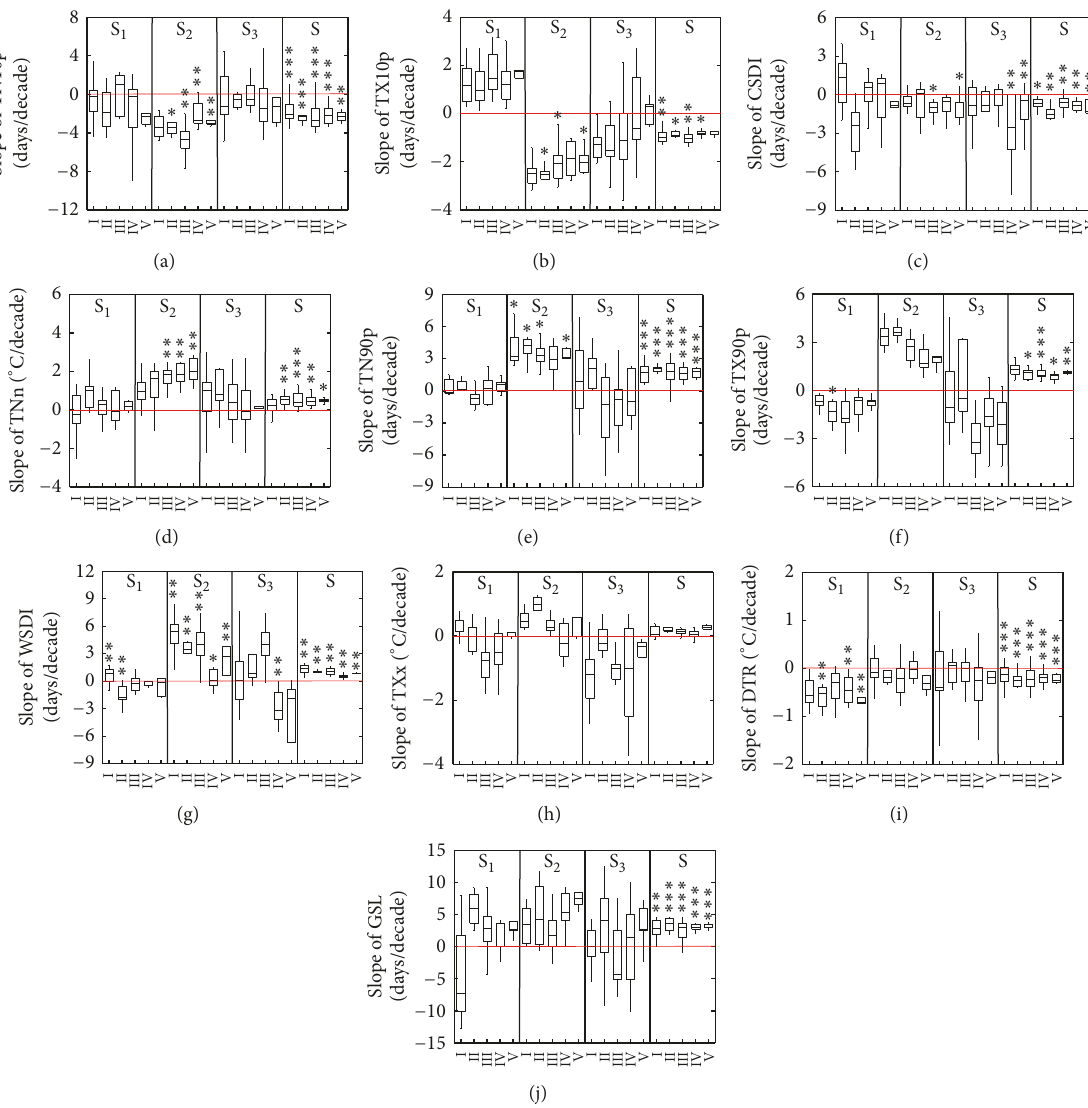
Figure 8: Box-Plot of Slopes for extreme temperature indices across the five subregions in different stages. (a) TN10p, (b) TX10p, (c) CSDI, (d) TNn, (e) TN90p, (f) TX90p, (g) WSDI, (h) TXx, (i) DTR, and (j) GSL. S 1 is 1960–1978, S 2 is 1979–2000, S 3 is 2000–2014, S is 1960–2014. ∗ ∗ ∗ is 0.001 level of significance, ∗∗ is 0.01 level of significance, and ∗ is 0.05 level of